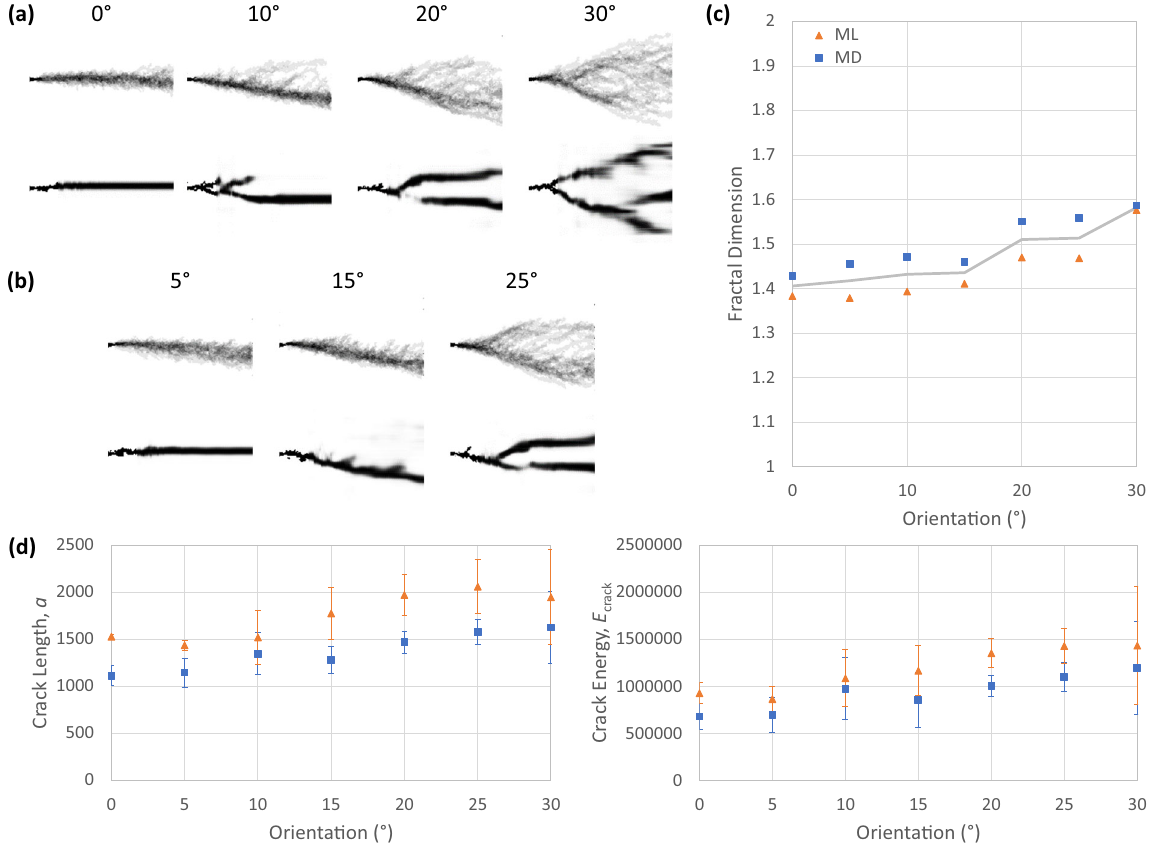
Fig. 3 Evaluating predictive power of ML model. Calibrated ML predictions line up not just with a graphene orientations used for the training data, but also b orientations the model has never seen before. The c fractal dimensions of ML-predicted fracture paths between the training and test orientations are of comparable accuracy, indicating that the model has correctly learned fracture behavior without over fi tting to the speci fi c training orientations. Quantitatively, d the fracture toughness values ML predicts only slightly overestimate crack energy values. Data points and error bars represent the mean and standard deviation over 11 sets of fracture